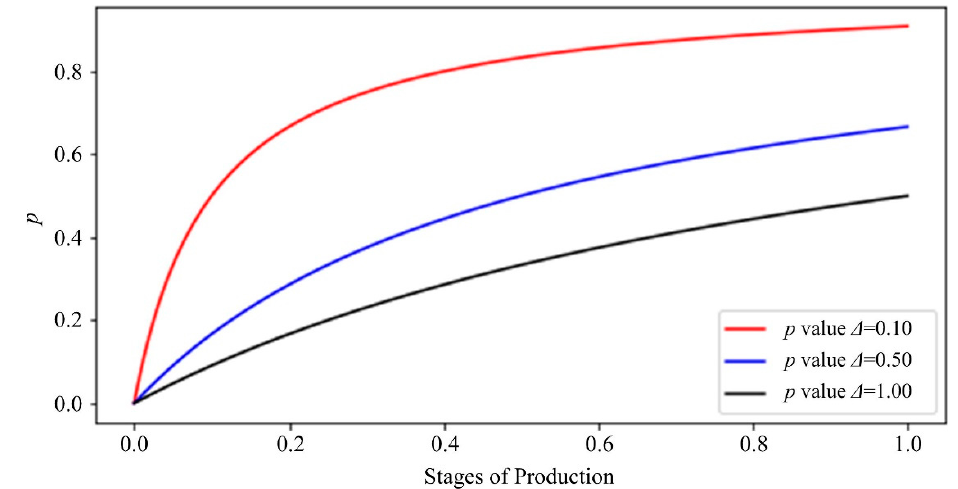
Figure 2. Importance coefficient curve of different processing state coefficients.